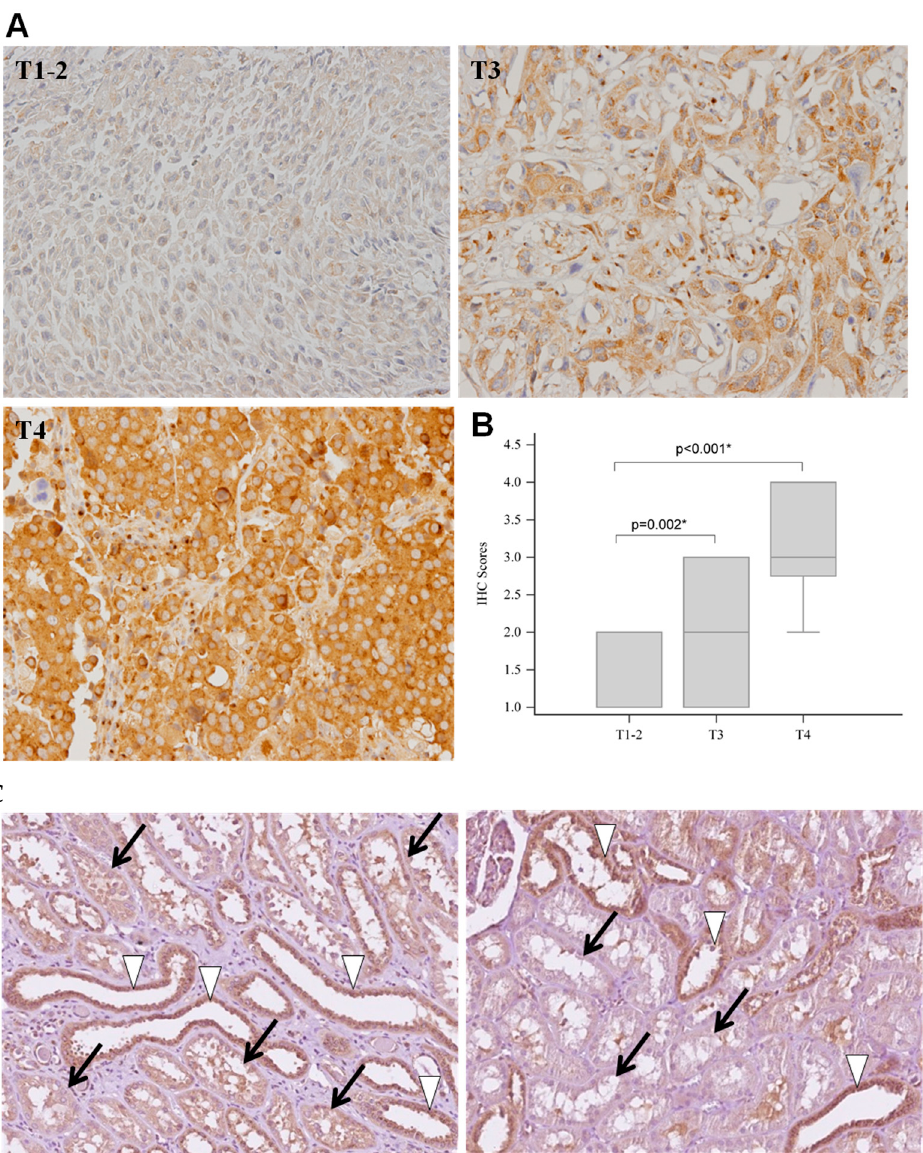
Figure 1. Up-regulation of FGFR3 in renal pelvis tissues from Caucasian patients with urothelial carcinoma. Tissue microarray slides containing sections from Caucasian patients with renal pelvis urothelial carcinoma at stages T1–2 ( n = 62), T3 ( n = 17), and T4 ( n = 5) were subjected to immuno- histochemistry (IHC) staining with FGFR3. ( A ) Representative FGFR3-positive stained images from stages T1–2, T3, and T4. ( B ) Quantification of FGFR3 expression levels from IHC staining results (scores were from 1 to 4). Data are shown in box plots displaying 25% to 75% percentile. * indicates significance between the indicated groups. ( C ) Heterogeneous distribution of FGFR3 in normal renal tubular epithelium. Note that proximal renal tubules (black arrows) usually show weak FGFR3 expression (score 1+), while distal tubules (white arrowheads) in the same specimen likely display stronger FGFR3 signals (score